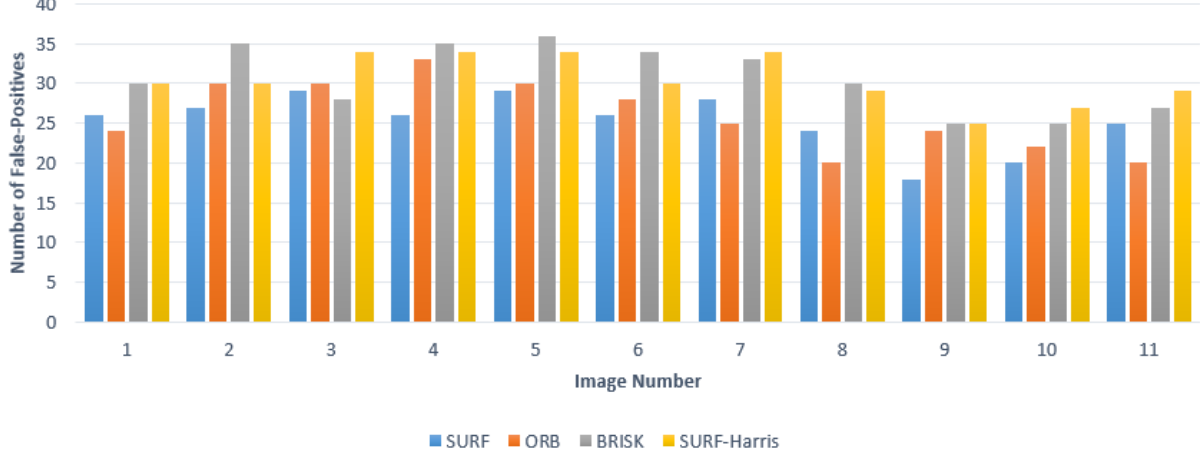
Figure 20. Number of false-positives detected amongst the 50 best interest points detected in each image of dataset